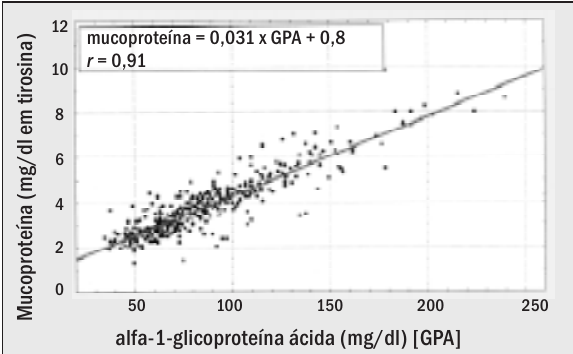
Figura 2 – Análise de regressão linear entre alfa-1-glicoproteína ácida (GPA) e mucoproteína expressa em tirosina. O coeficiente de correlação ( r ) e a equação de